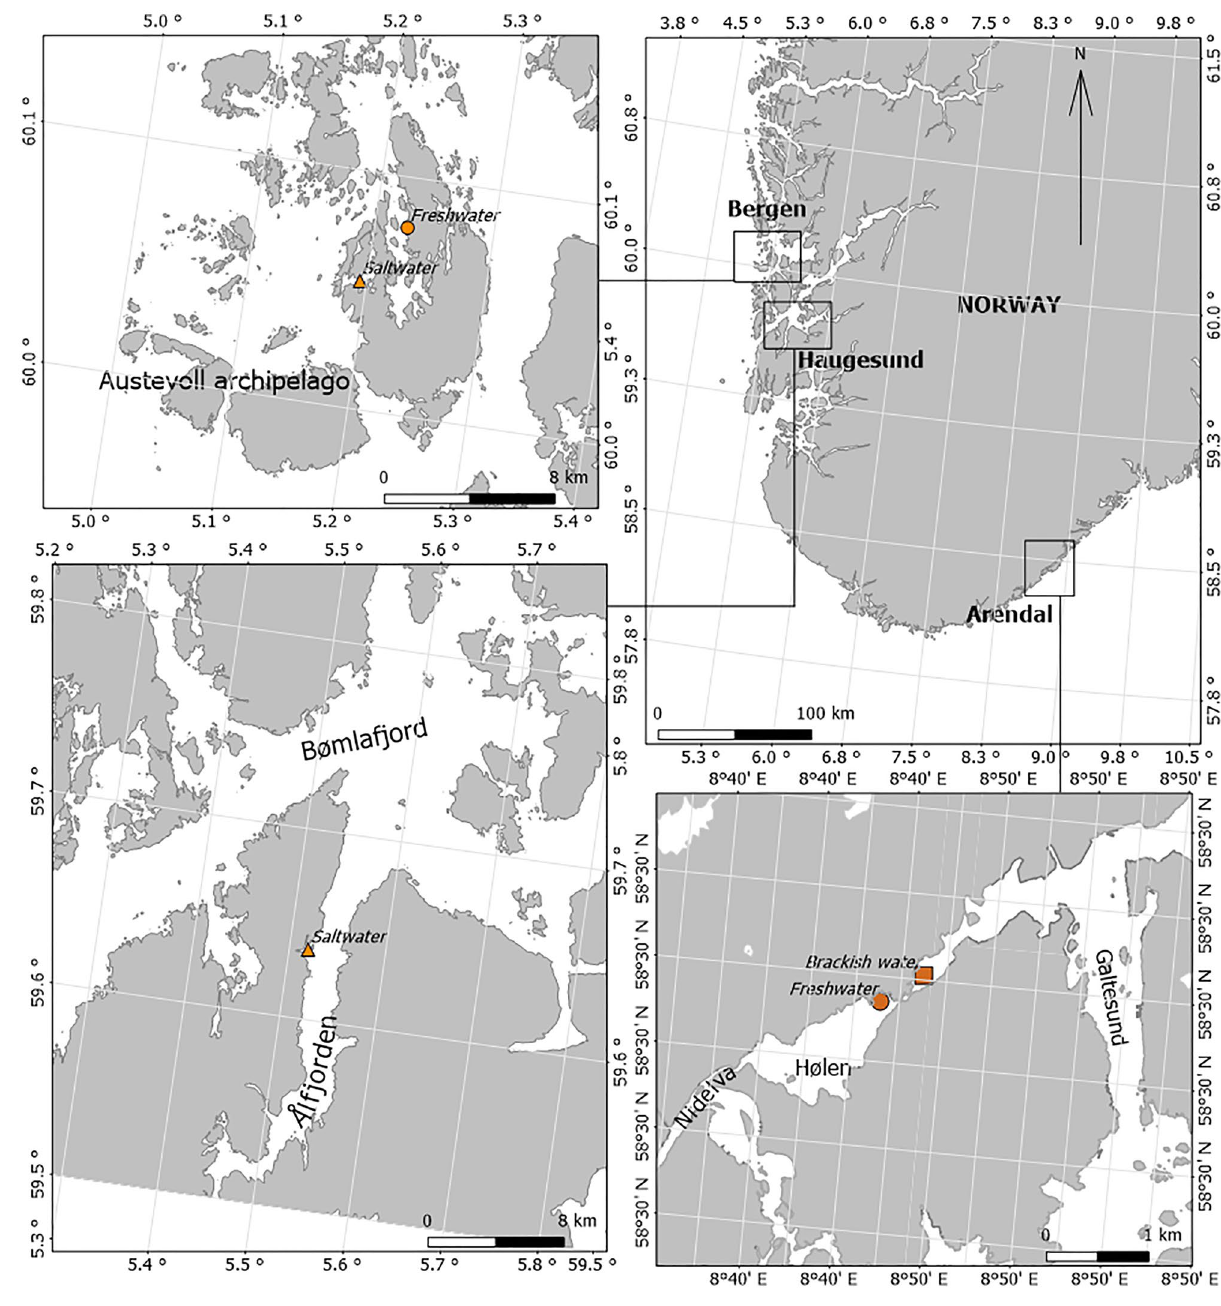
Figure 1. Map of the Norwegian locations of European eel